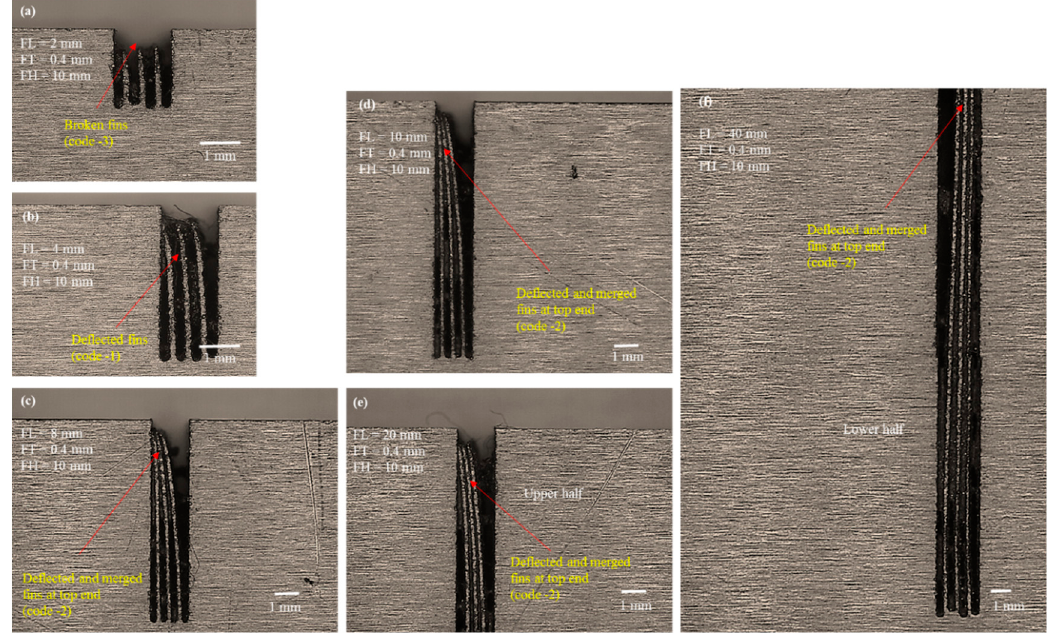
Figure 8. Microscopic analysis of structure traits under the second phase of experimentation with designed fin thickness (FT_d) of 0.4 mm and FH 10 mm: ( a ) FL 2 mm, ( b ) FL 4 mm, ( c ) FL 8 mm, ( d ) FL 10 mm, ( e ) FL 20 mm upper half, and ( f ) FL 40 mm lower half.